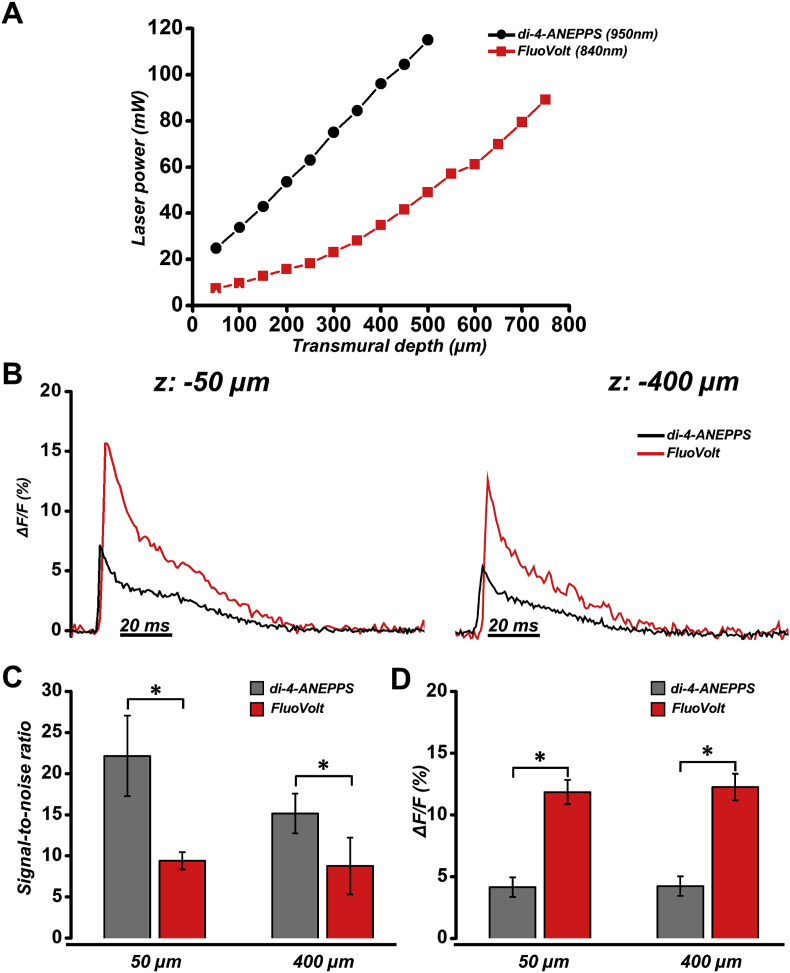
Fluorescence properties of FluoVolt and di-4-ANEPPS. (A) Transmural laser power curves for FluoVolt and di-4-ANEPPS. (B) Representative superimposed averaged AP traces recorded with FluoVolt and di-4-ANEPPS at 50 μm (left) and 400 μm (right) below the epicardial surface. (C) S/N of FluoVolt and di-4-ANEPPS signals at 50 μm and 400 μm deep. (D) Percentage change of fluorescence in APs recorded with FluoVolt and di-4-ANEPPS at 50 μm and 400 μm deep. *P < 0.05, Student's t-test (unpaired).